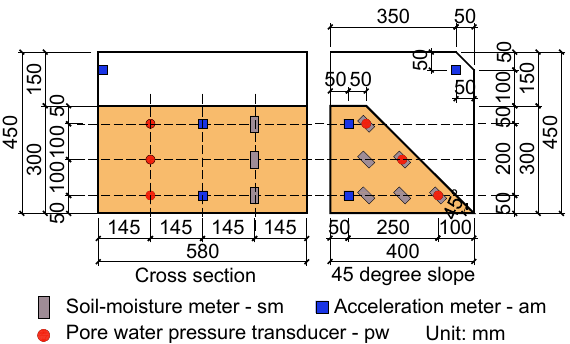
Figure 8. Overall view of apparatus in this study.